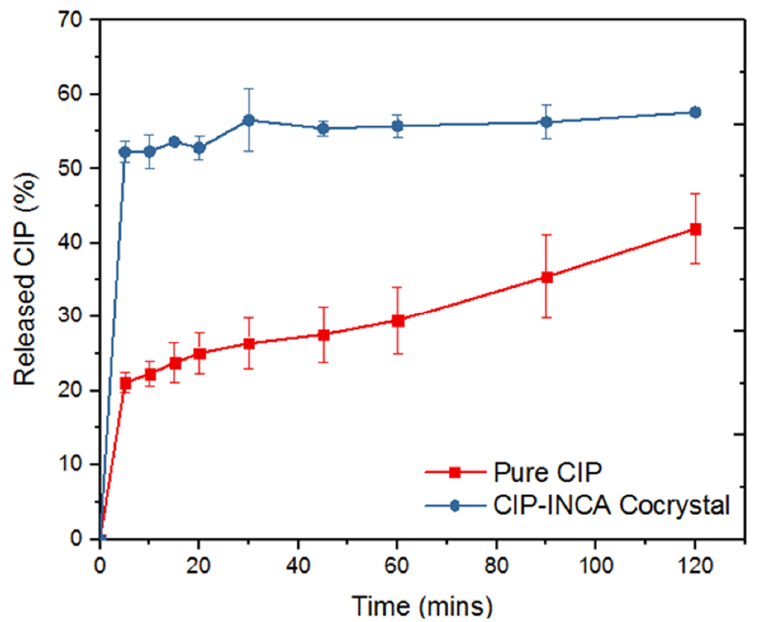
Figure 13. Dissolution rate of pure CIP and CIP–INCA cocrystal in phosphate buffer pH